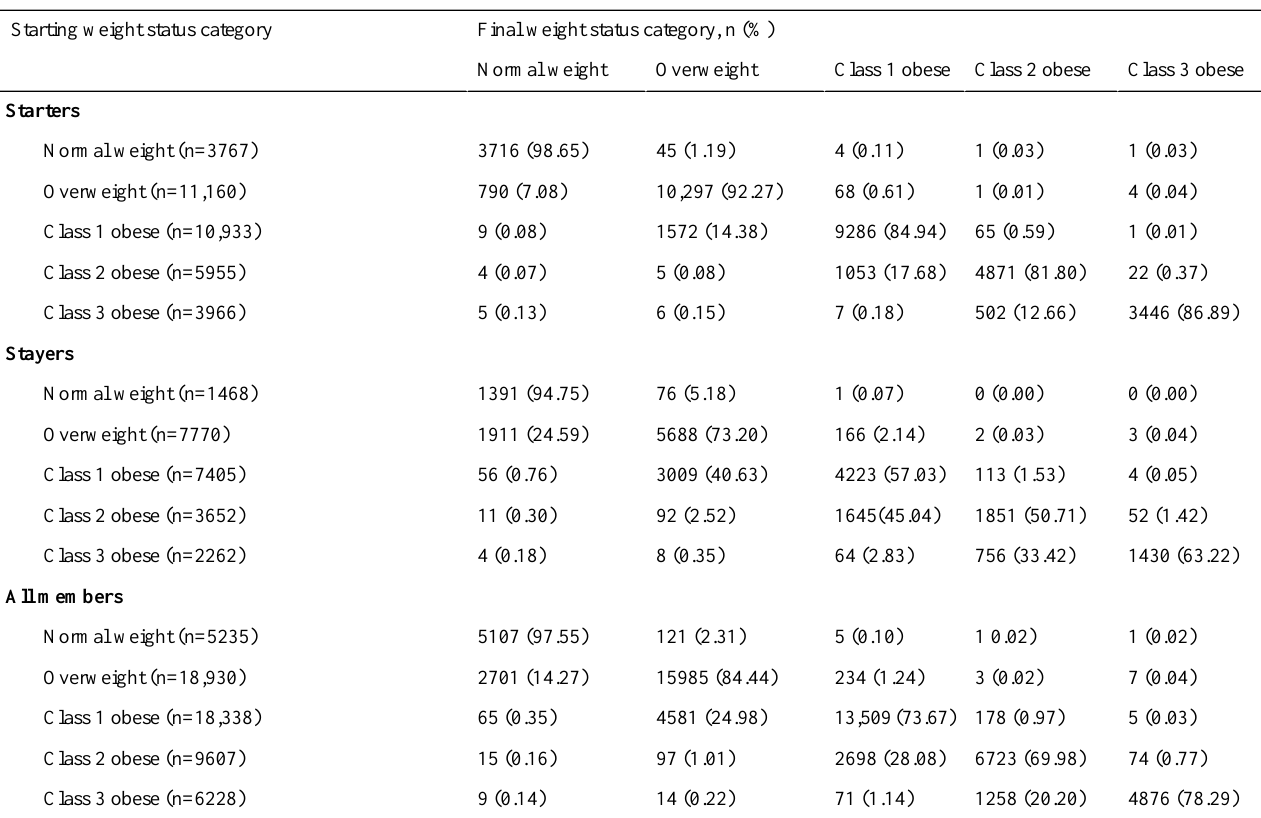
b Proportion of the sample within each category of weight loss: weight gain, 0 to less than 5% of starting body weight lost, 5% to less than 10% of starting body weight lost, and greater than or equal to 10% of starting body weight lost. Table 4. Shift in body weight status category as a percentage of starting weight status category for starters (n=37,028), stayers (n=22,658), and all members (N=59,686) in the CSIRO Total Wellbeing Diet